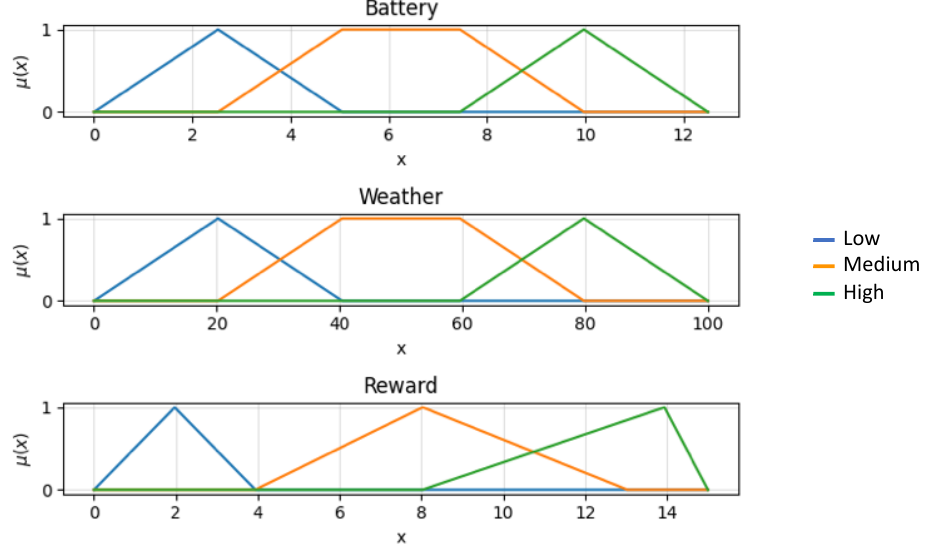
Figure 5. Inputs and output variables with their respective sets used to generate the fuzzy system.